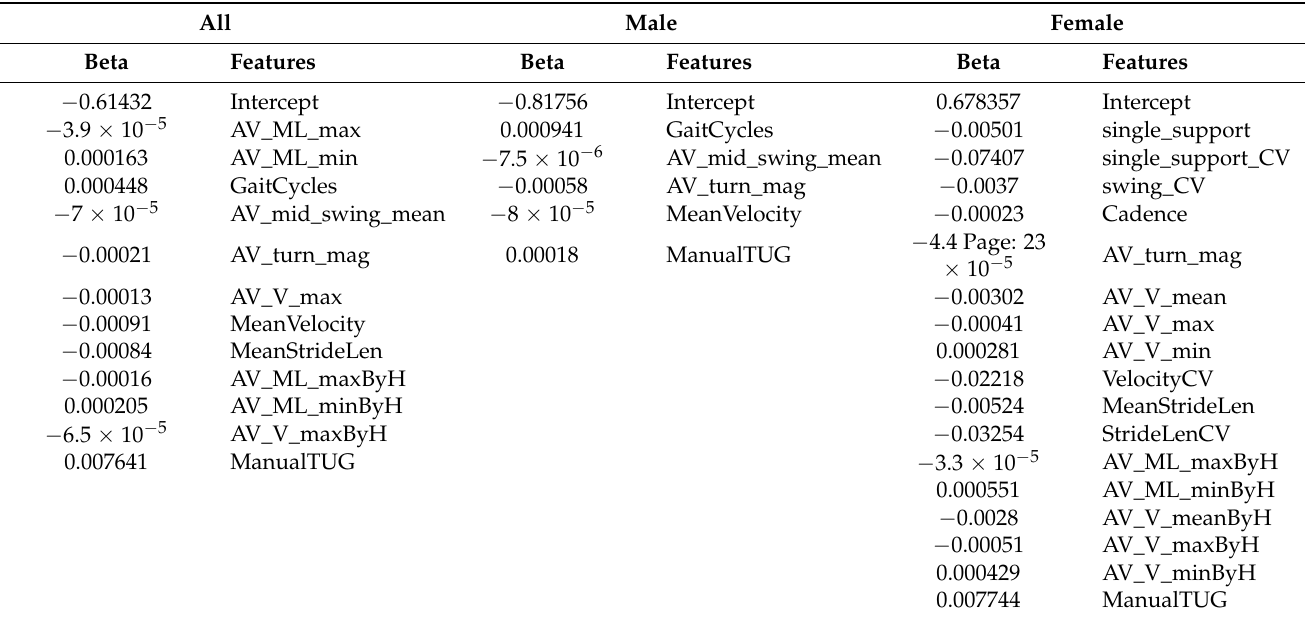
Table A7. TD-Fallers falls count model coefficients. Beta refers to Poisson regression coefficients, chosen through an elastic net procedure.